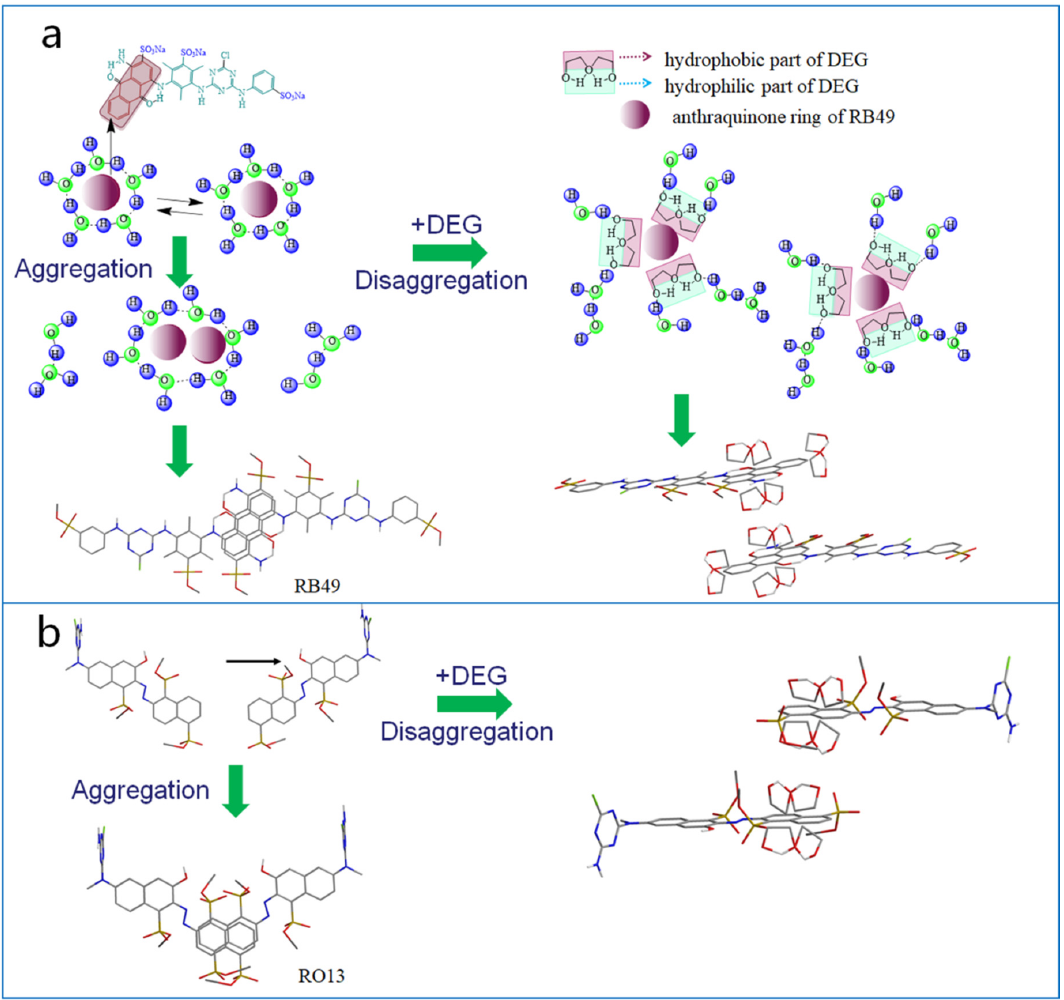
Figure 3. Schematic diagram of interaction between dye molecules and separation effect of DEG molecules to dye molecules: ( a ) Blue 49 and ( b ) Orange